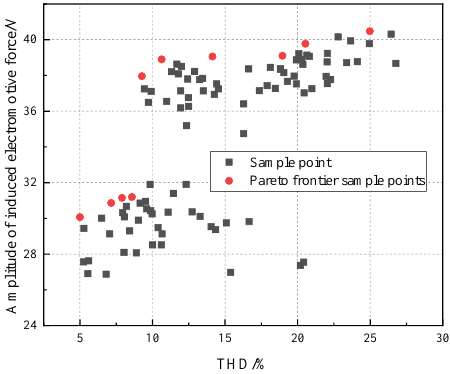
Figure 12. Pareto frontier distribution map.